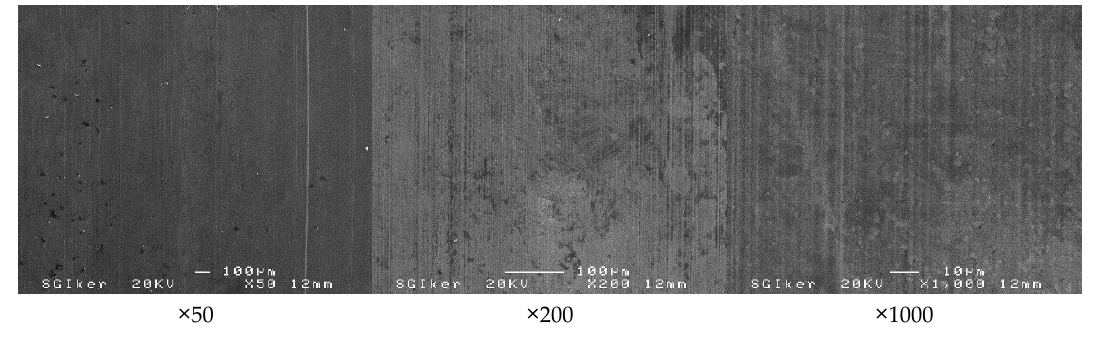
Figure 20. AA ‐ 5754 ‐ N0 disk. Figure 20. AA-5754-N0